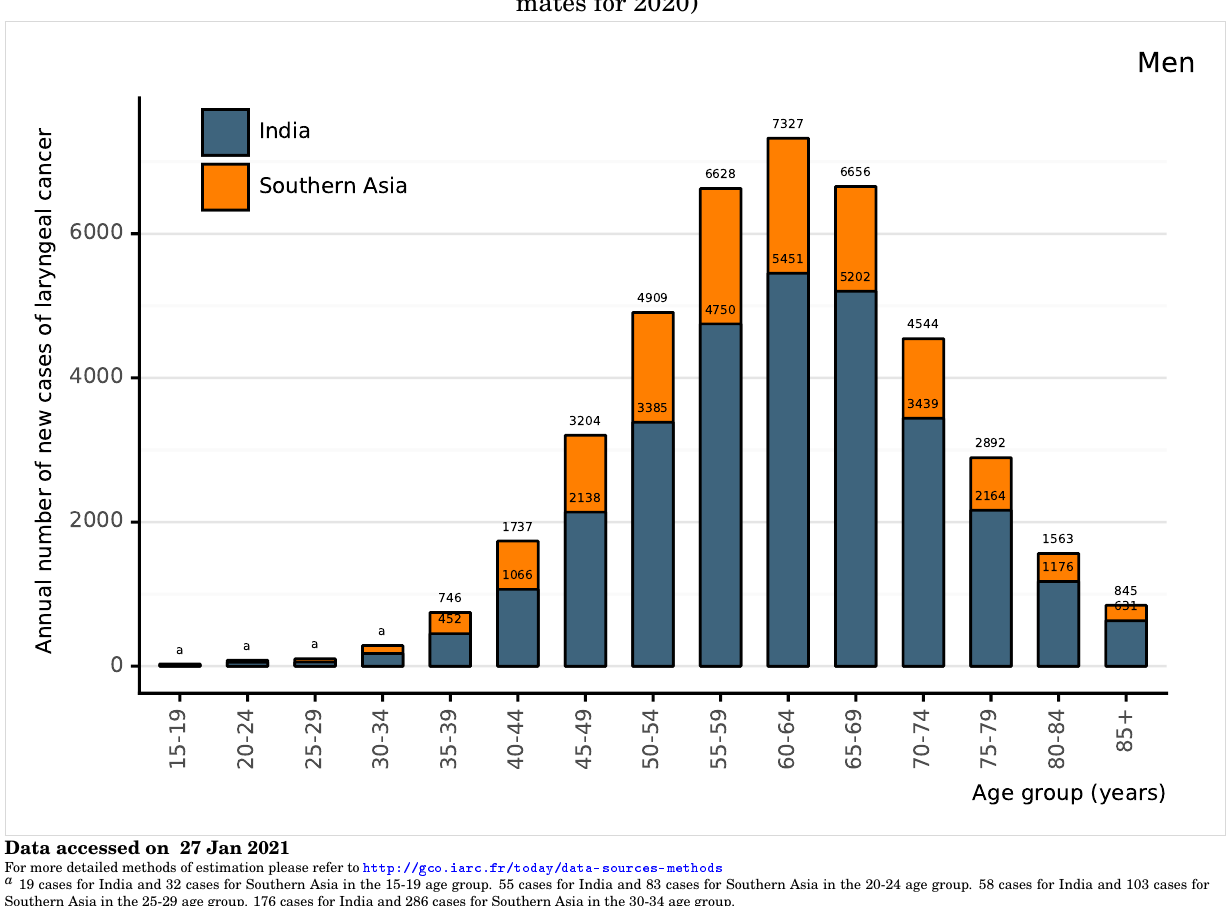
Figure 101: Annual number of new cases of laryngeal cancer among men by age group in India